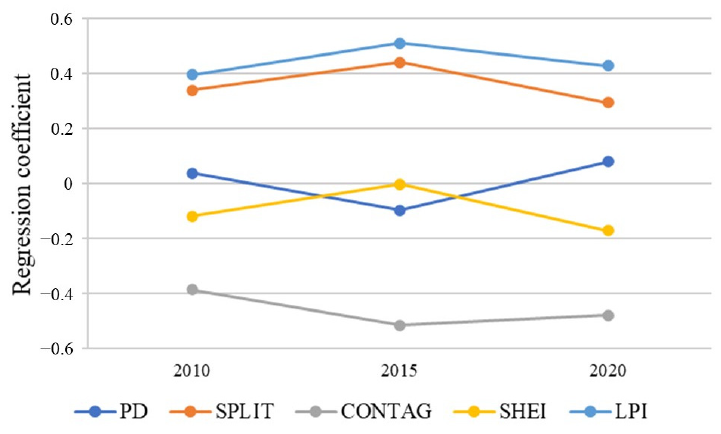
Figure 6. Regression coefficient of the landscape pattern index.